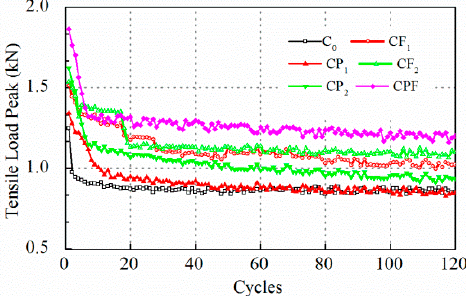
Figure 9. Tensile load peak at 0.1 mm crack opening.